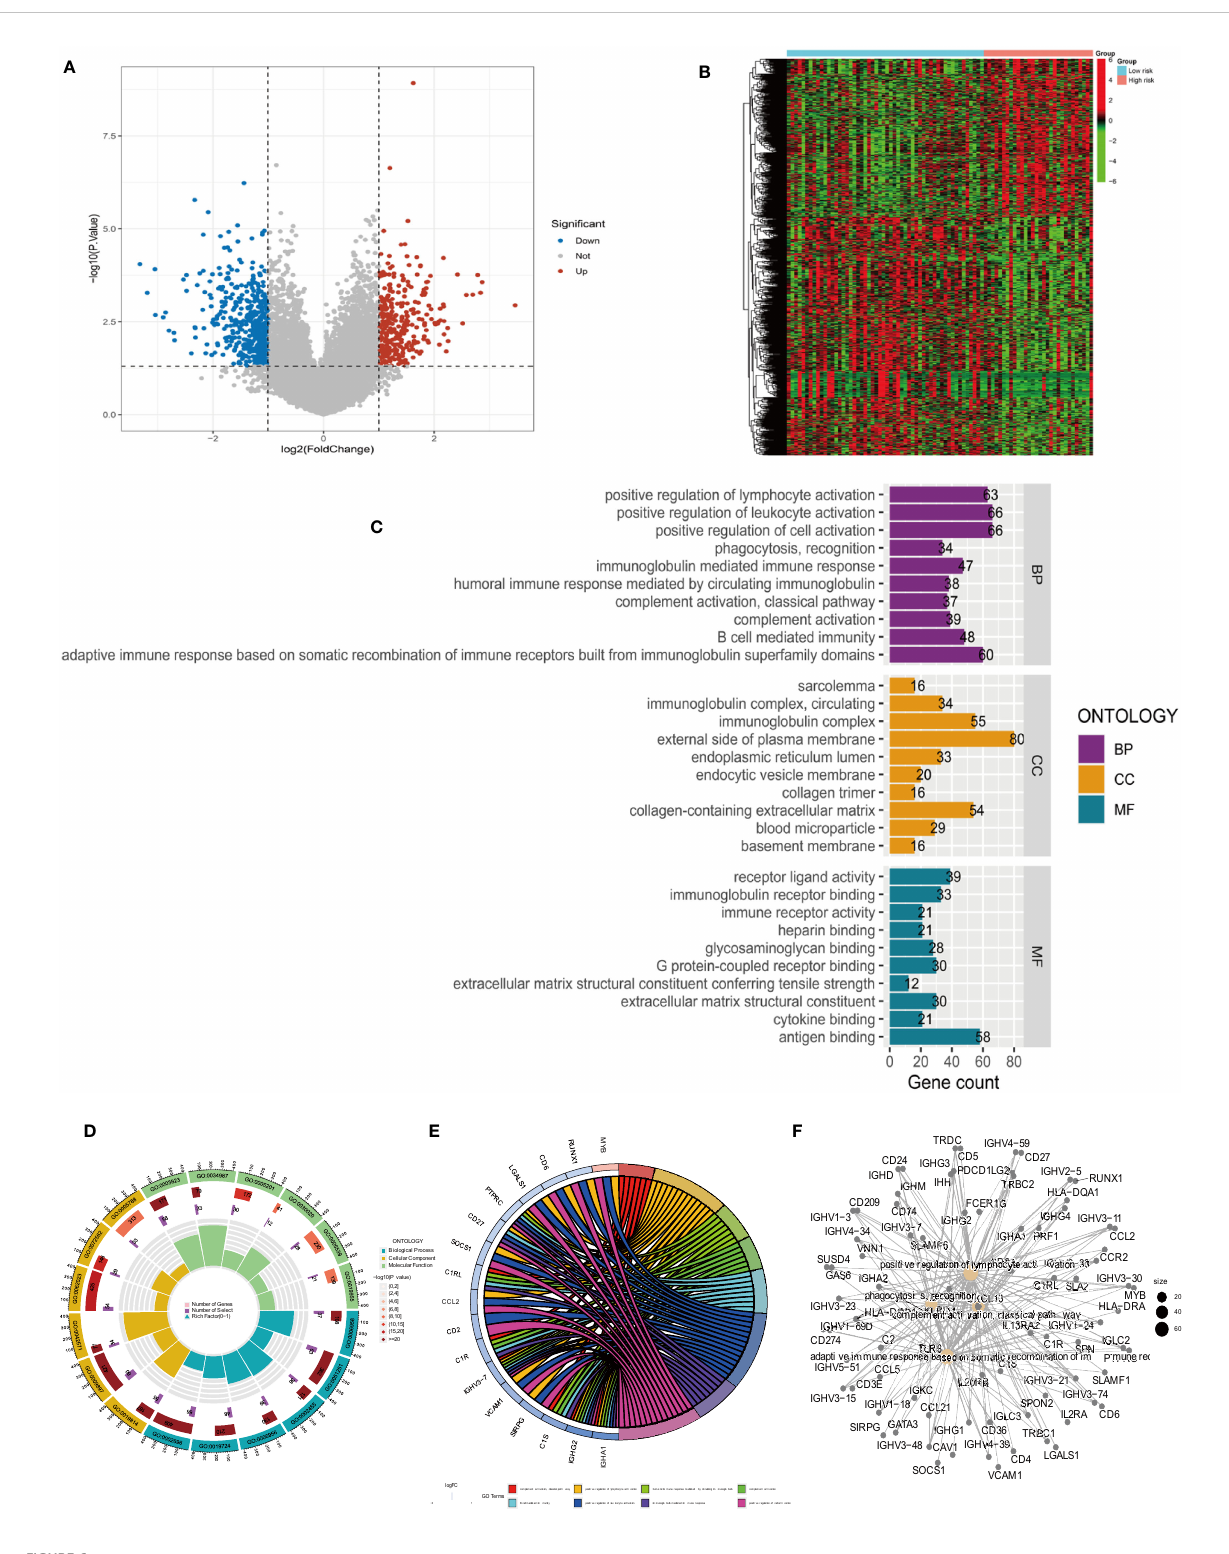
FIGURE 6 Differential analysis and GO functional enrichment analysis of the TARGET database in the high- and low-risk groups. (A) Volcano plot of differentially express(DEGs): red for high expression and blue for low expression. (B) Heat map of DEGs, with high expression in red and low expression in green. (C) Gene Ontology (GO) analysis for the DEGs between the high- and low-risk groups. (D) Circle plots for the analysis. (E) GO enrichment analysis of DEARLncs. (F) Network of biological processes in GO